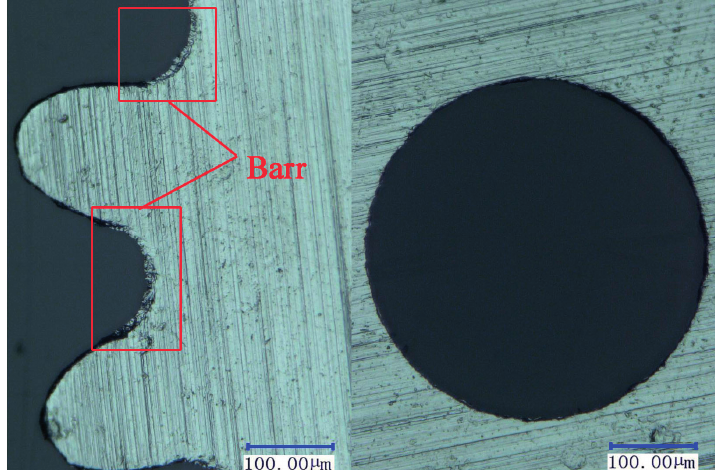
Figure 4. The detailed top-view picture of the gears and